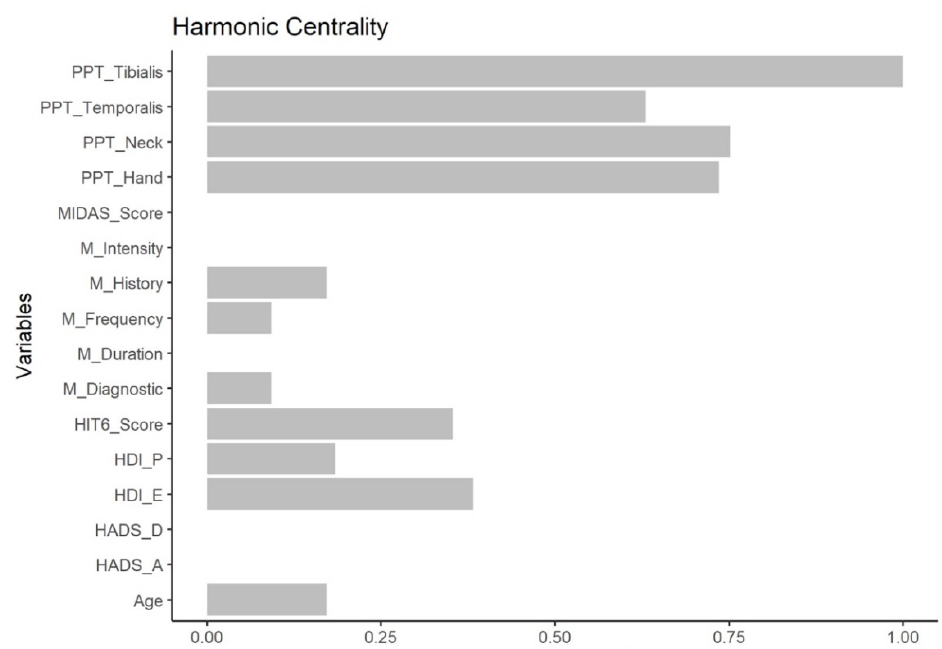
Figure 2. Centrality values (1: maximal importance; 0: no importance) of Strength and Betweenness of each node in the network.